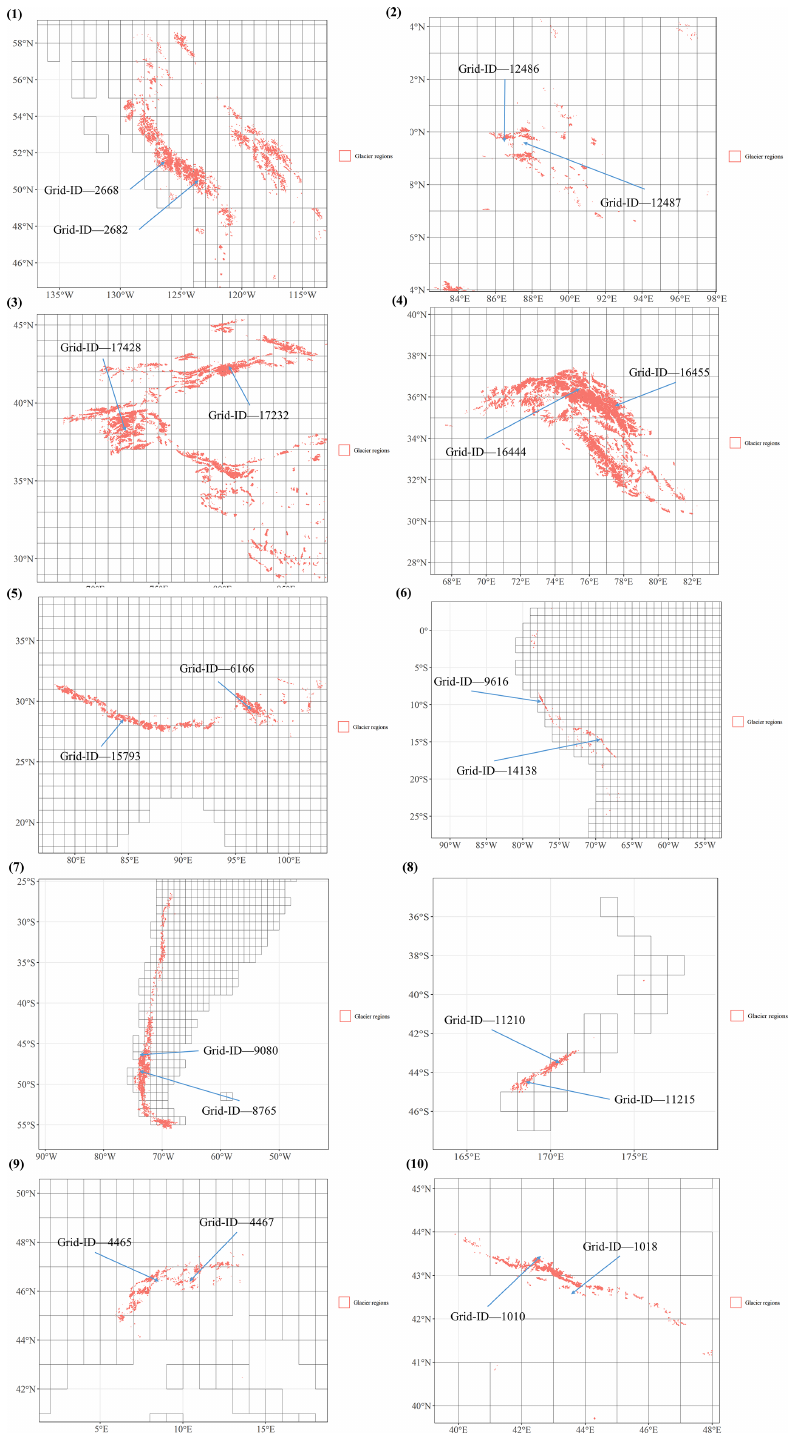
Figure 6. The 10 glacial regions within the 60 ◦ S–60 ◦ N latitudes. Two representative GRACE grid points in each region were selected to analyze the temporal detection of floods and correspond to the time series in Fig. 7. The 10 regions are as follows: (1) glacial regions in western Canada and the US, (2) glacial regions in North Asia, (3) glacial regions in Central Asia, (4) glacial regions in western South Asia, (5) glacial regions in eastern South Asia, (6) glacial regions at low latitudes, (7) glacial regions in the southern Andes, (8) glacial regions in New Zealand, (9) glacial regions in central Europe and (10) glacial regions in central eastern Caucasus.